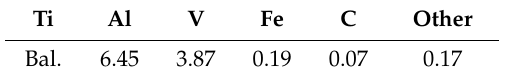
Table 2. WAAM manufacturing parameters.